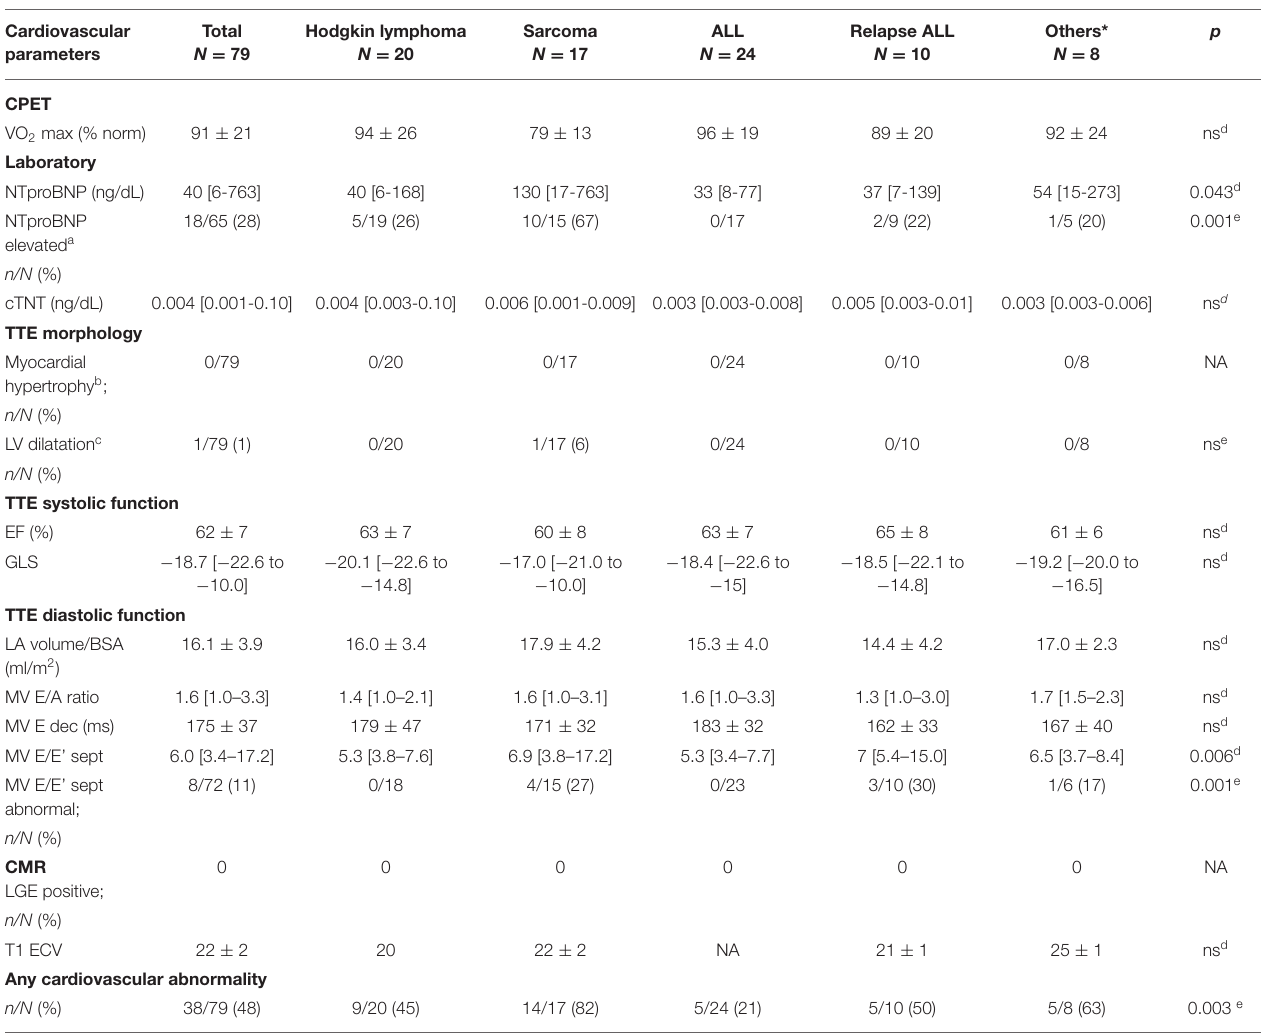
TABLE 3 | Cardiovascular findings according to oncologic diagnosis. Cardiovascular